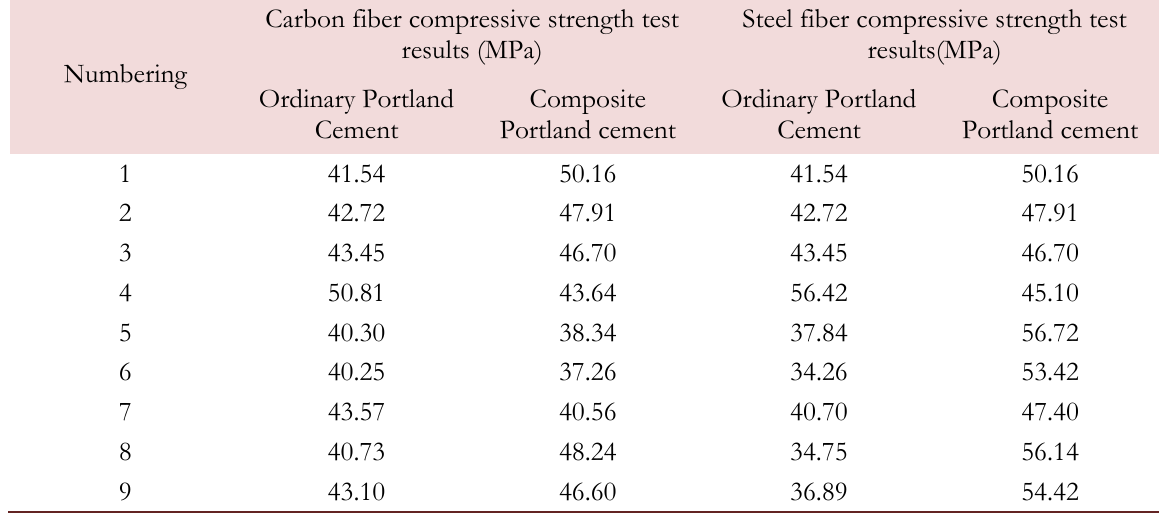
Table 4: Anti-splitting test results.